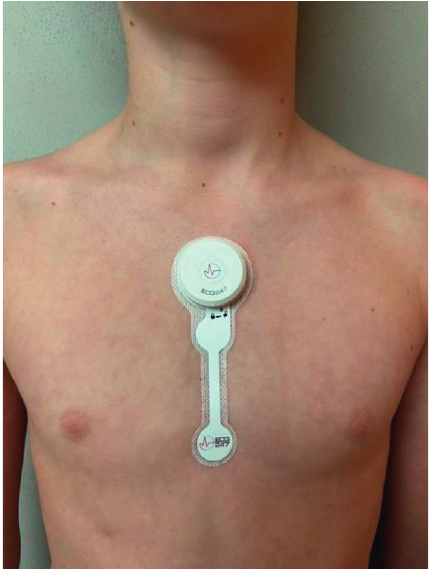
Figure 2: The ECG247 Smart Heart Sensor attached to the patient’s